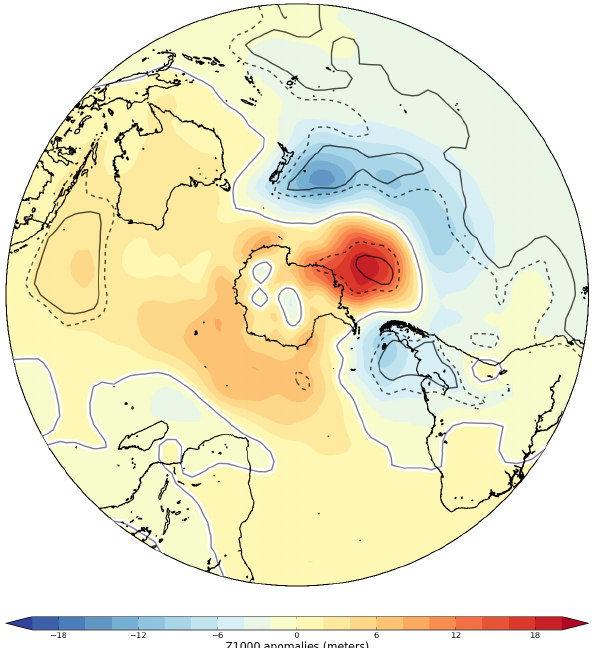
Figure 10. July–August geopotential height anomaly at 1000hPa ( z 1000) over the Southern Hemisphere for 1839–1851CE deter- mined by an ensemble composite of reconstructions from the Rev- erend Davis diary temperatures and three tree-ring proxy data se- ries (same as Fig. 9). Anomaly height is in metres. Reanalysis data are courtesy of the National Centers for Environmental Prediction (NCEP). Confidence intervals (90th and 95th) are noted with black (dashed and solid) contour lines. Figure generated using the Past In- terpretation of Climate Tool (PICT) courtesy of National Institute of Water and Atmospheric Research (NIWA). See Lorrey (2014) and http://pict.niwa.co.nz for details.